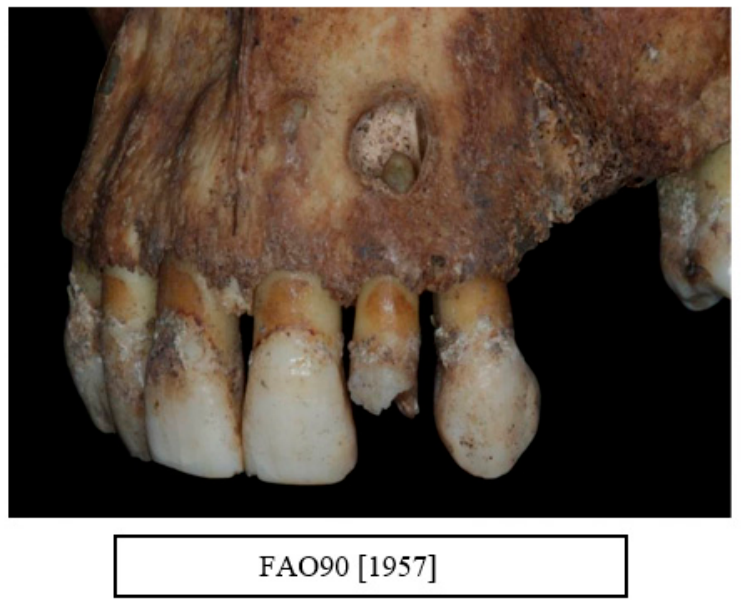
Figure 6. Occlusal view showing an extensive carious lesion in the upper right first molar (UR6) extending to the pulp chamber (courtesy of the Museum of London).